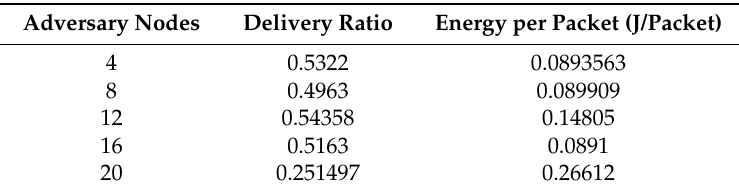
Table 4. Influence of malicious nodes on network